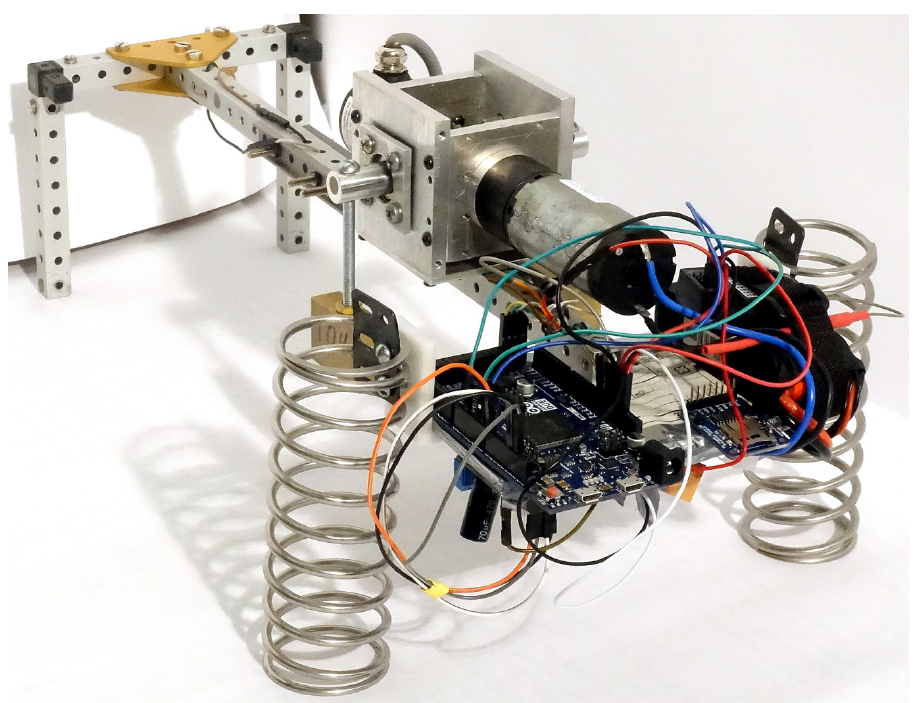
Figure 14. Isometric view of experimental set